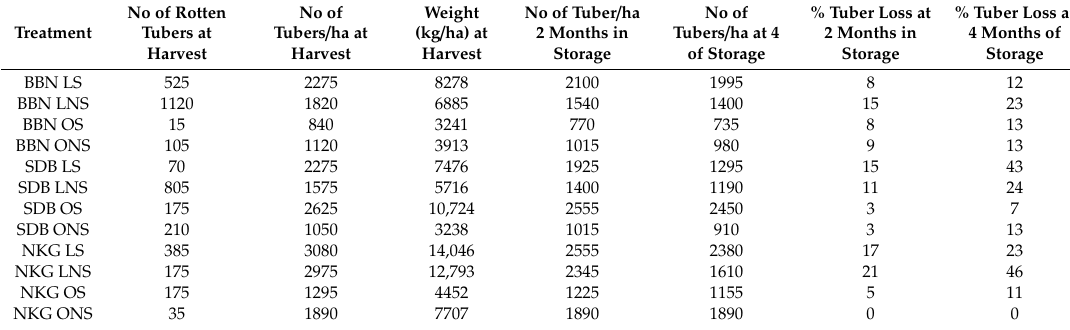
Table 6. Levels of rotting and